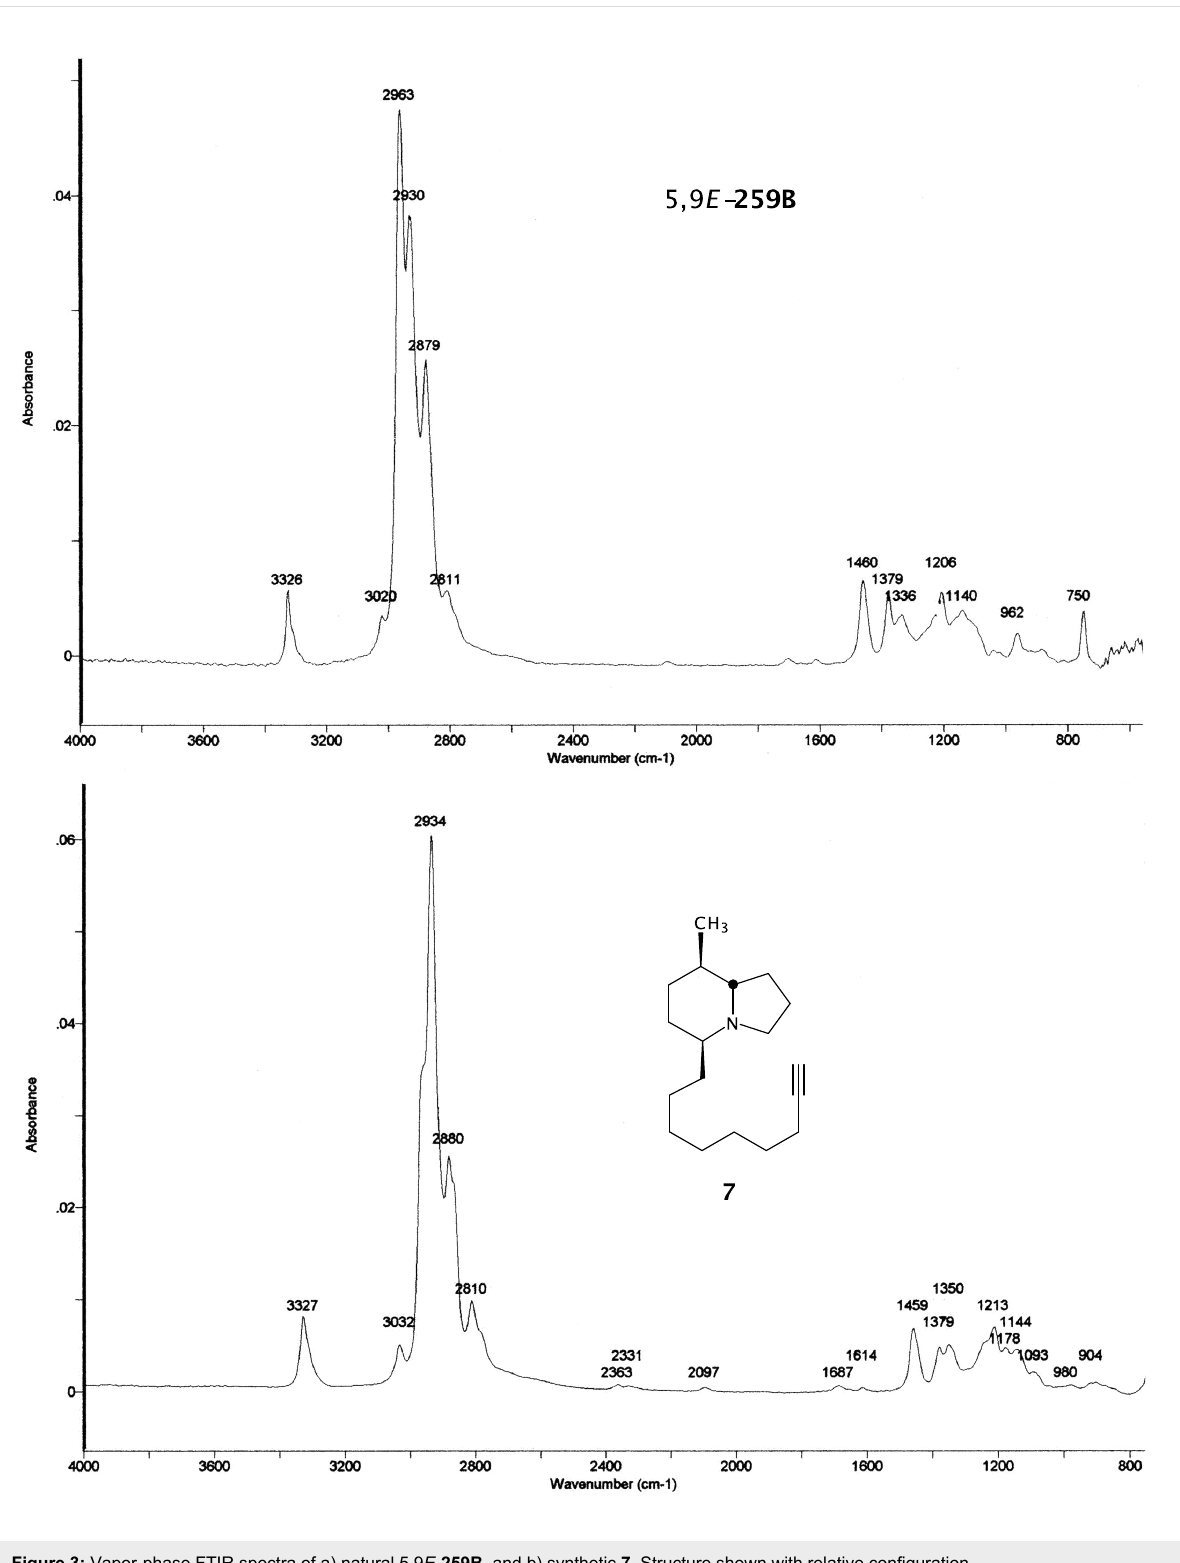
Figure 3: Vapor-phase FTIR spectra of a) natural 5,9 E - 259B , and b) synthetic 7 . Structure shown with relative